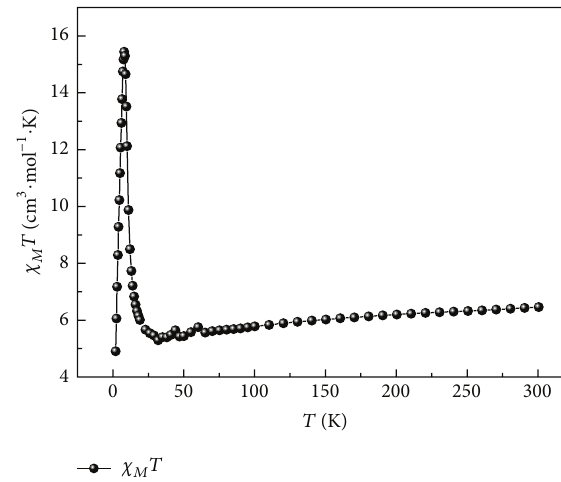
Figure 7: 𝜒 𝑚 𝑇 versus 𝑇 for the compound.